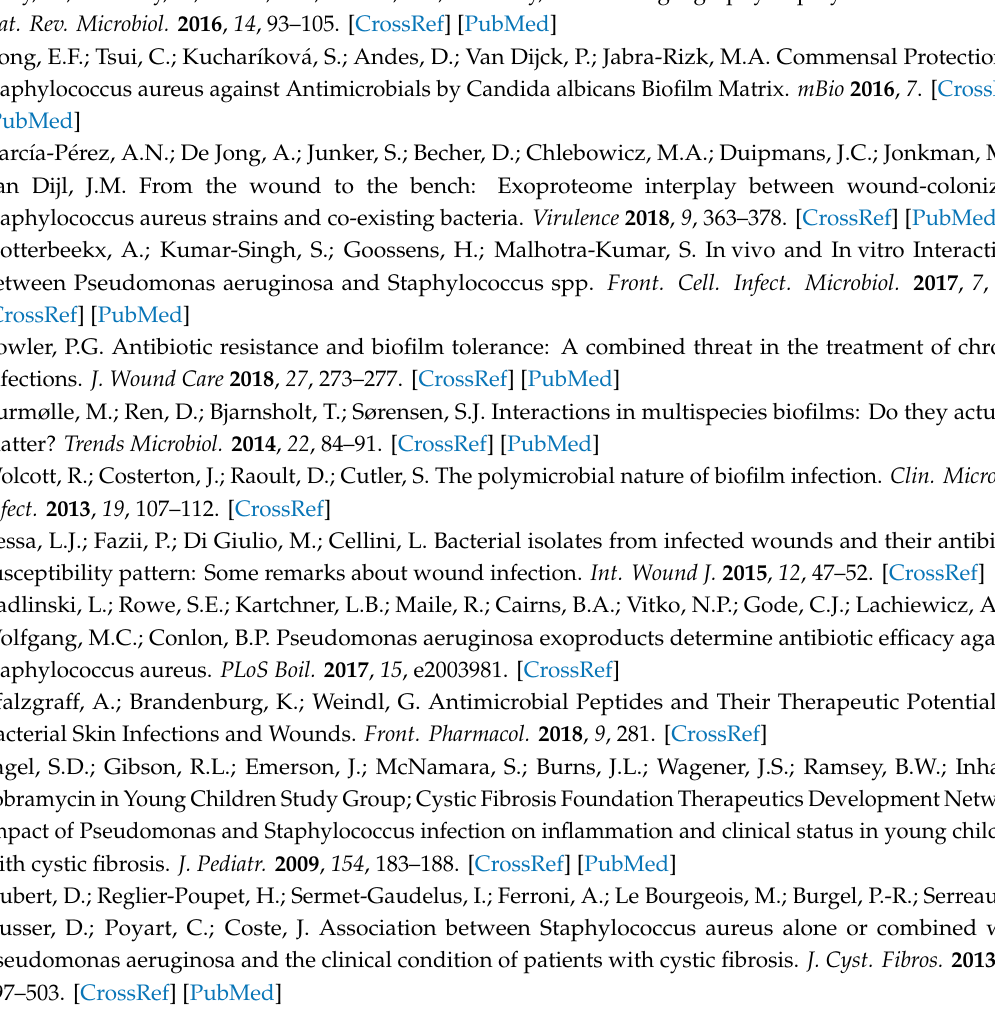
Table A1. Antimicrobial resistance pattern of the multidrug-resistant isolates used in this study. Isolate Antimicrobial resistance pattern Pa3 ATM, CIP, FEP, GEN Pa4 ATM, CAZ, CIP, FEP, IPM PA002 AMK, CIP, COL, GEN, TOB PA004 CIP, GEN, IPM, TOB, TZP PA006 AMK, CAZ, CIP, COL, FEP, GEN, IPM, TOB Sa1 AMC, AMP, CIP, FOX, TET Sa3 AMC, AMP, CIP, FOX, IPM SA007 CIP, CLI, ERI, GEN, LEV, MOX,